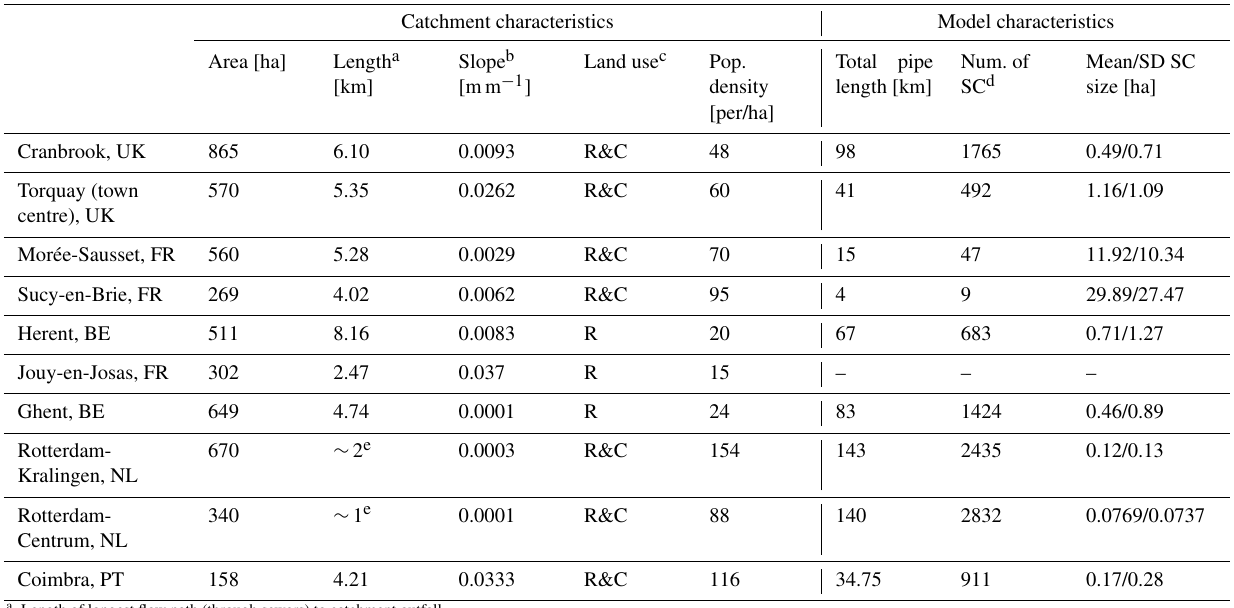
Table 1. General characteristics of the pilot urban catchments and their semi-distributed urban drainage models. Catchment characteristics